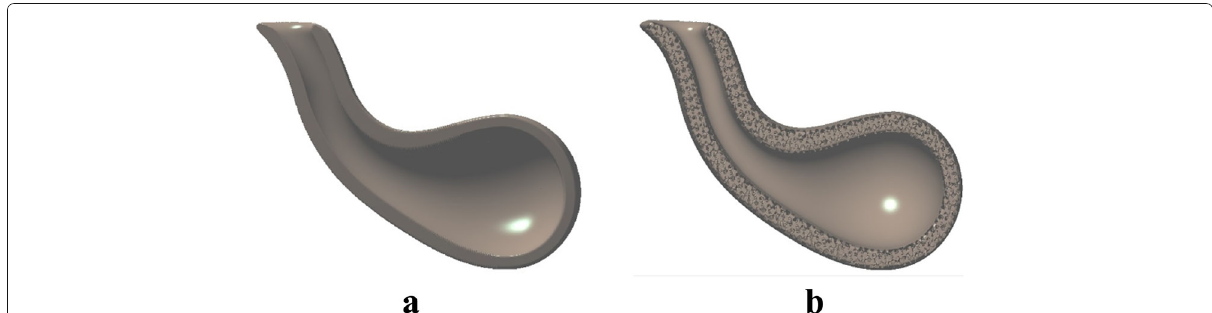
Fig. 10 a . Implicitly represented solid teapot spout. b . The external geometric appearance of the teapot spout and its internal material structure is